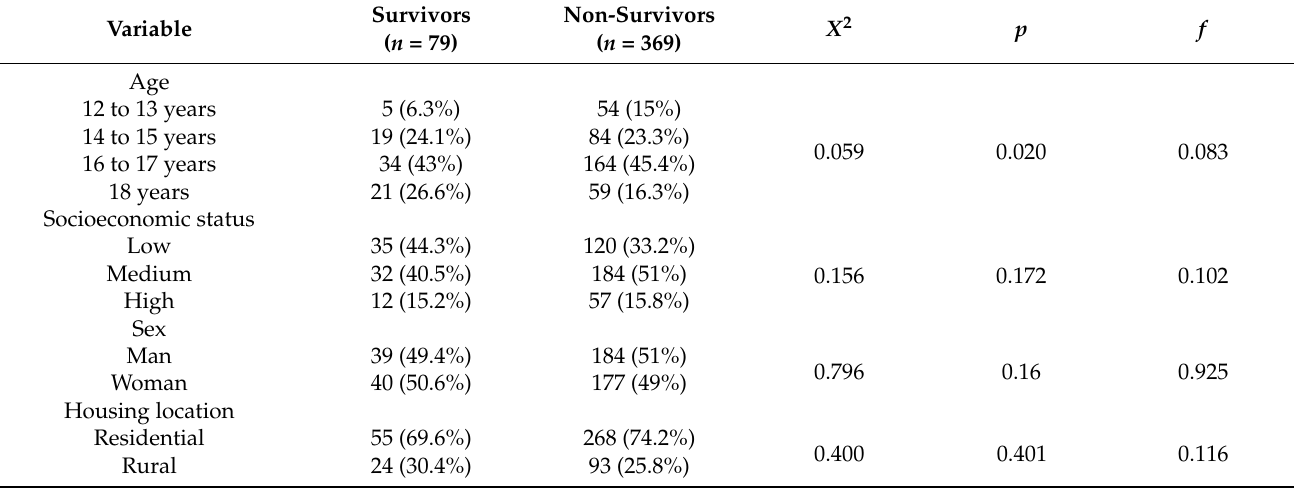
Table 1. Socio-demographic characteristics of adolescents as a function of suicide-survivor